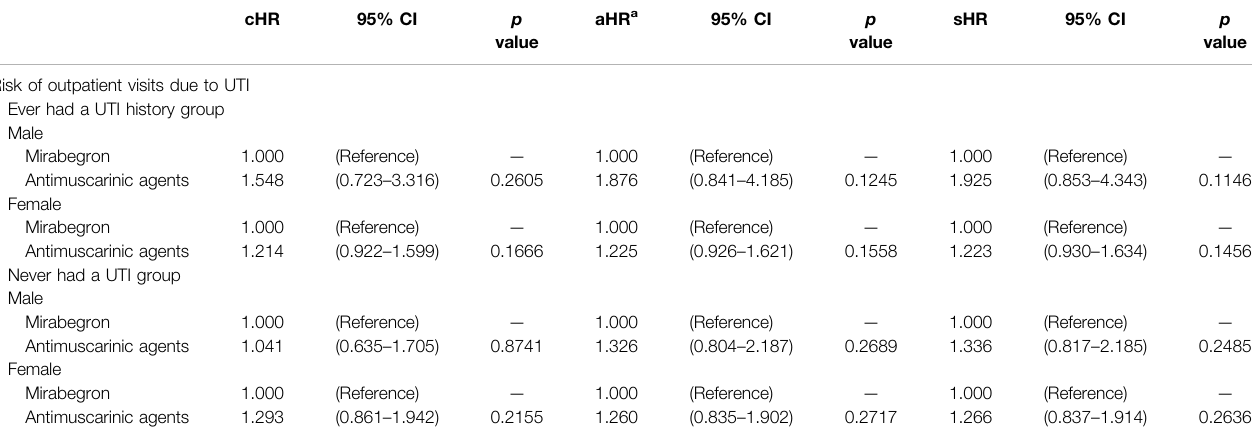
TABLE 5 | Risk of UTI (outpatient) in sensitivity analysis of drugs with different mechanisms.